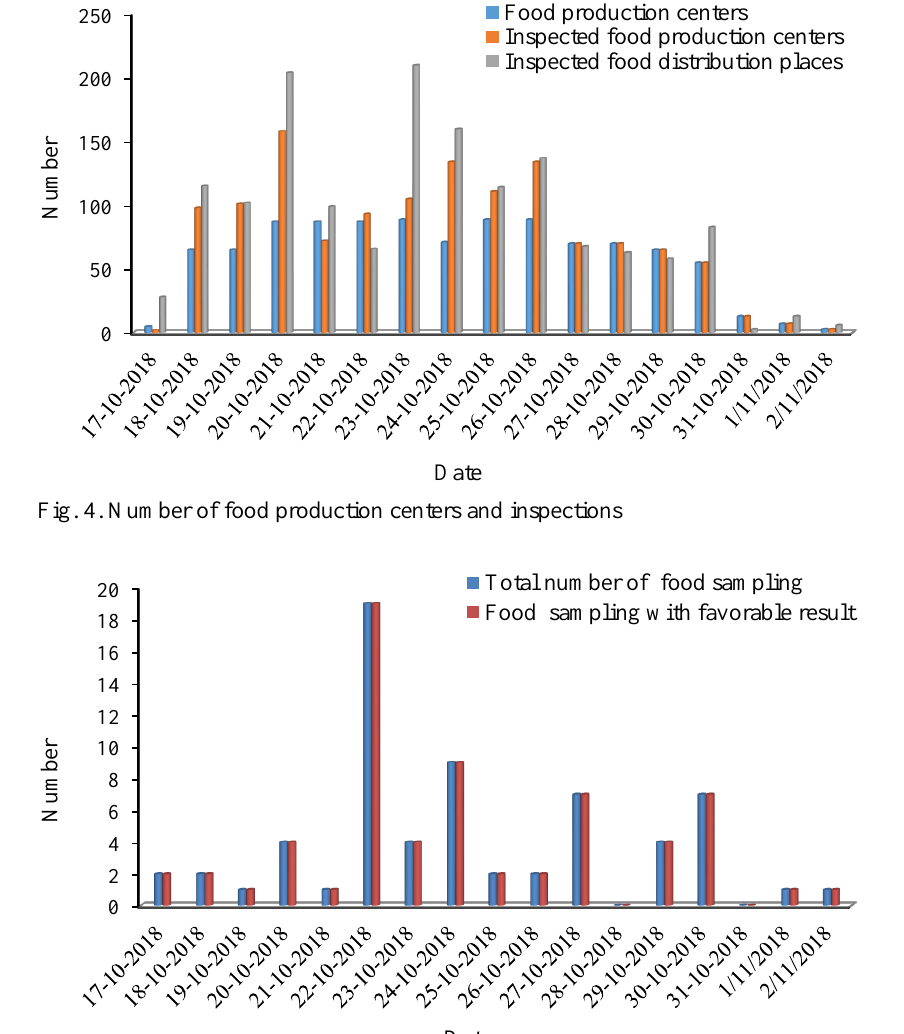
Fig. 5. Number of food samples and samples with favorable results